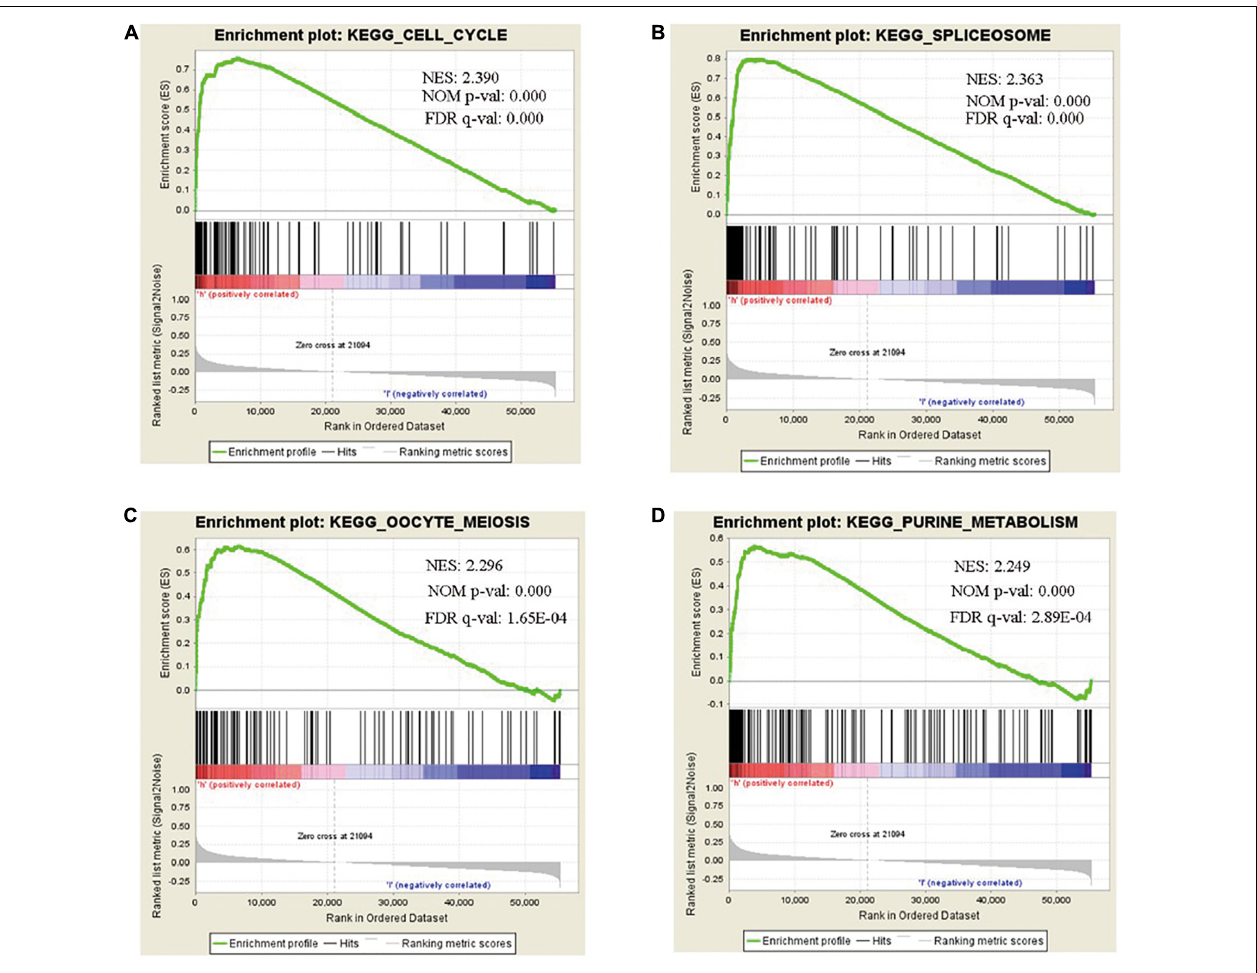
FIGURE 6 | Gene set enrichment analysis (GSEA) of SHMT2 in BLCA. GSEA analysis showed that SHMT2 may regulate the (A) cell cycle (NES = 2.390, NOM- P < 0.0001), (B) spliceosome (NES = 2.363, NOM- P < 0.0001), (C) oocyte meiosis (NES = 2.296, NOM- P < 0.0001), and (D) purine metabolism (NES = 2.249, NOM- P < 0.0001) pathways in BLCA development. P -value < 0.05 was recognized as statistically